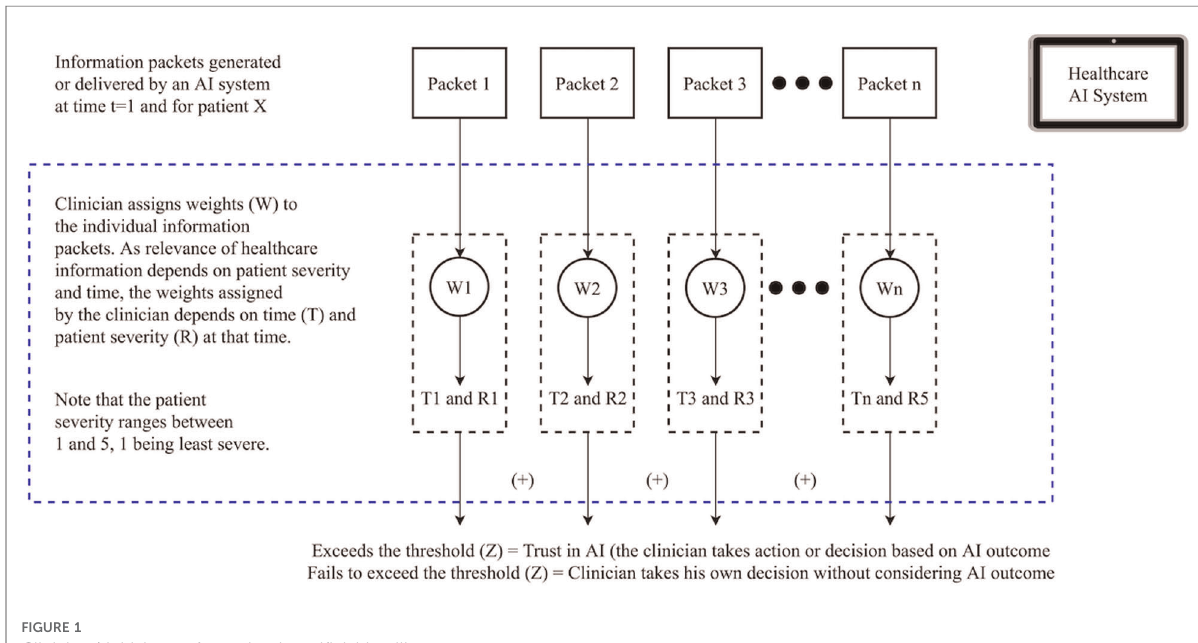
FIGURE 1 Clinicians ’ initial trust formation in arti fi cial